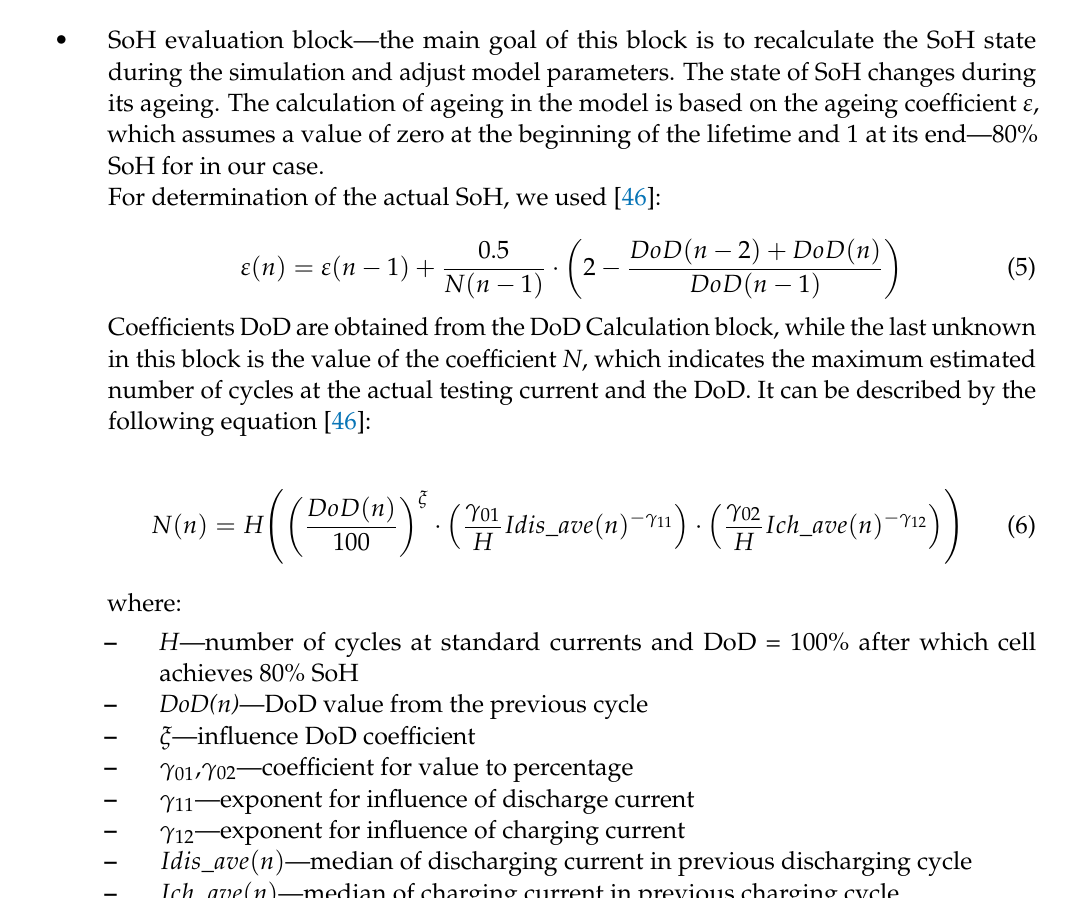
Figure 20. Block for calculating capacity.